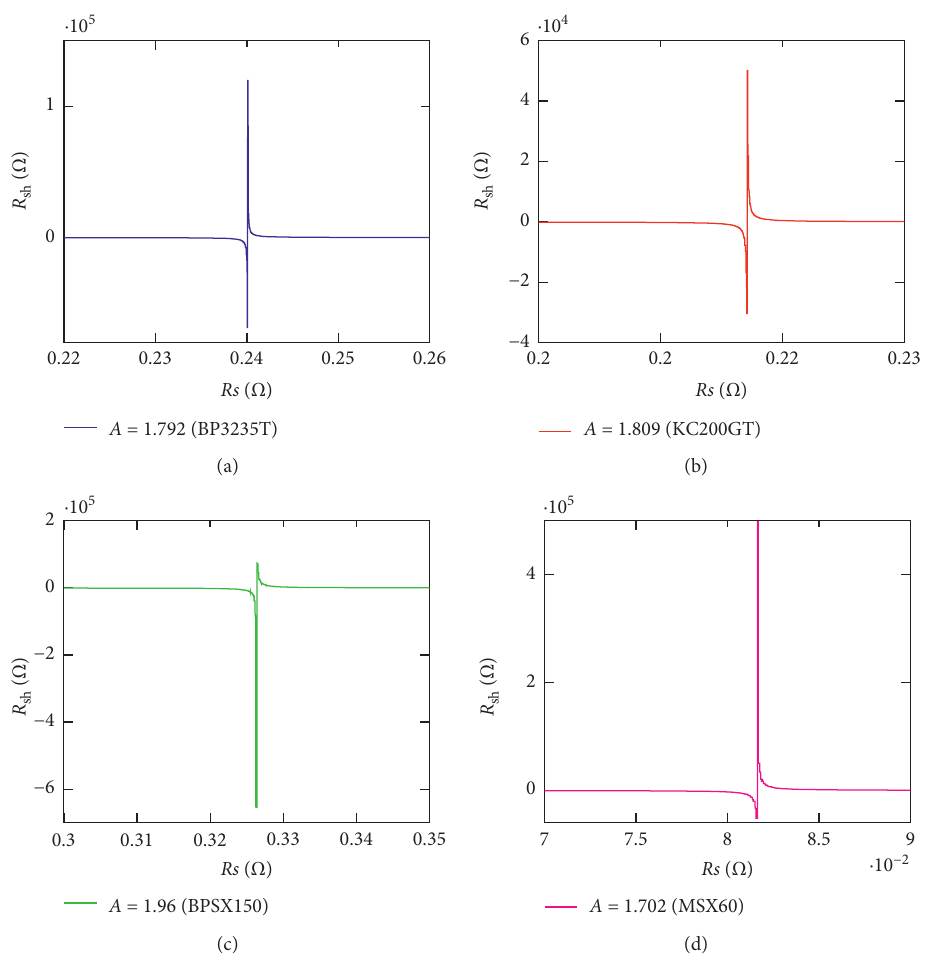
Figure 3: A graph of R sh vs R s at STC for (a) BP3235T, (b) Kyocera KC200GT, (c) BP-SX 150, and (d) Solarex